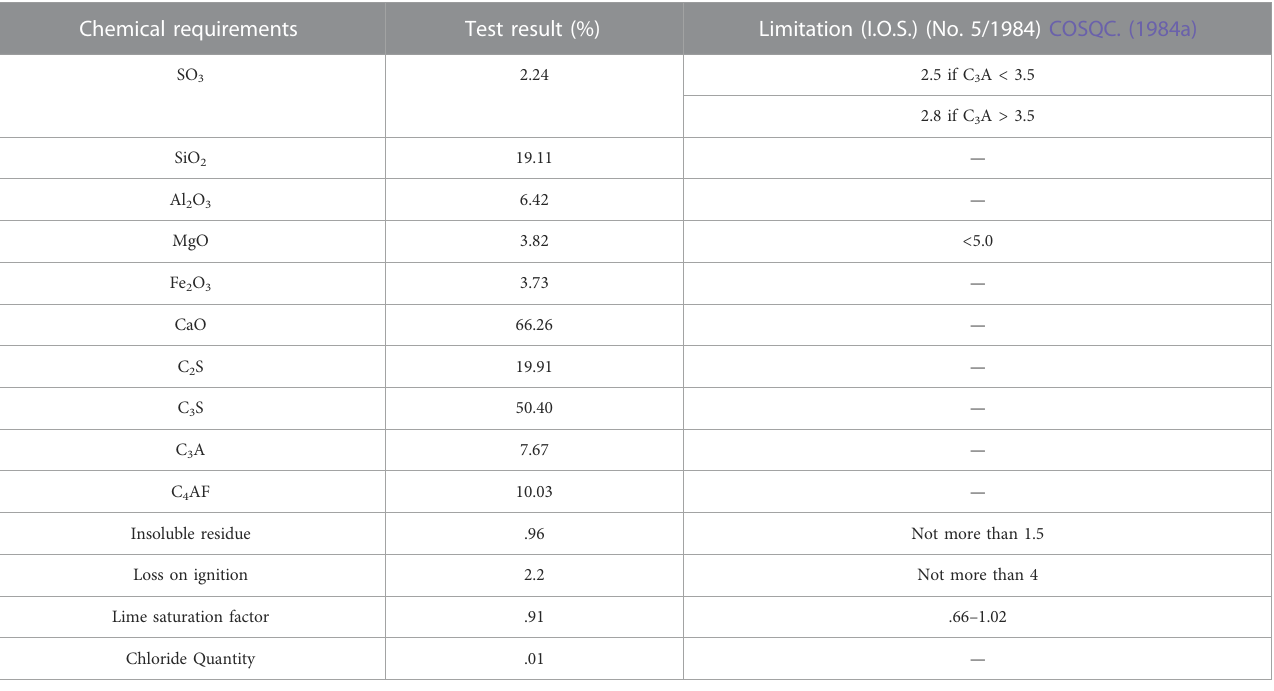
TABLE 1 The chemical characteristics of OPC. Chemical requirements